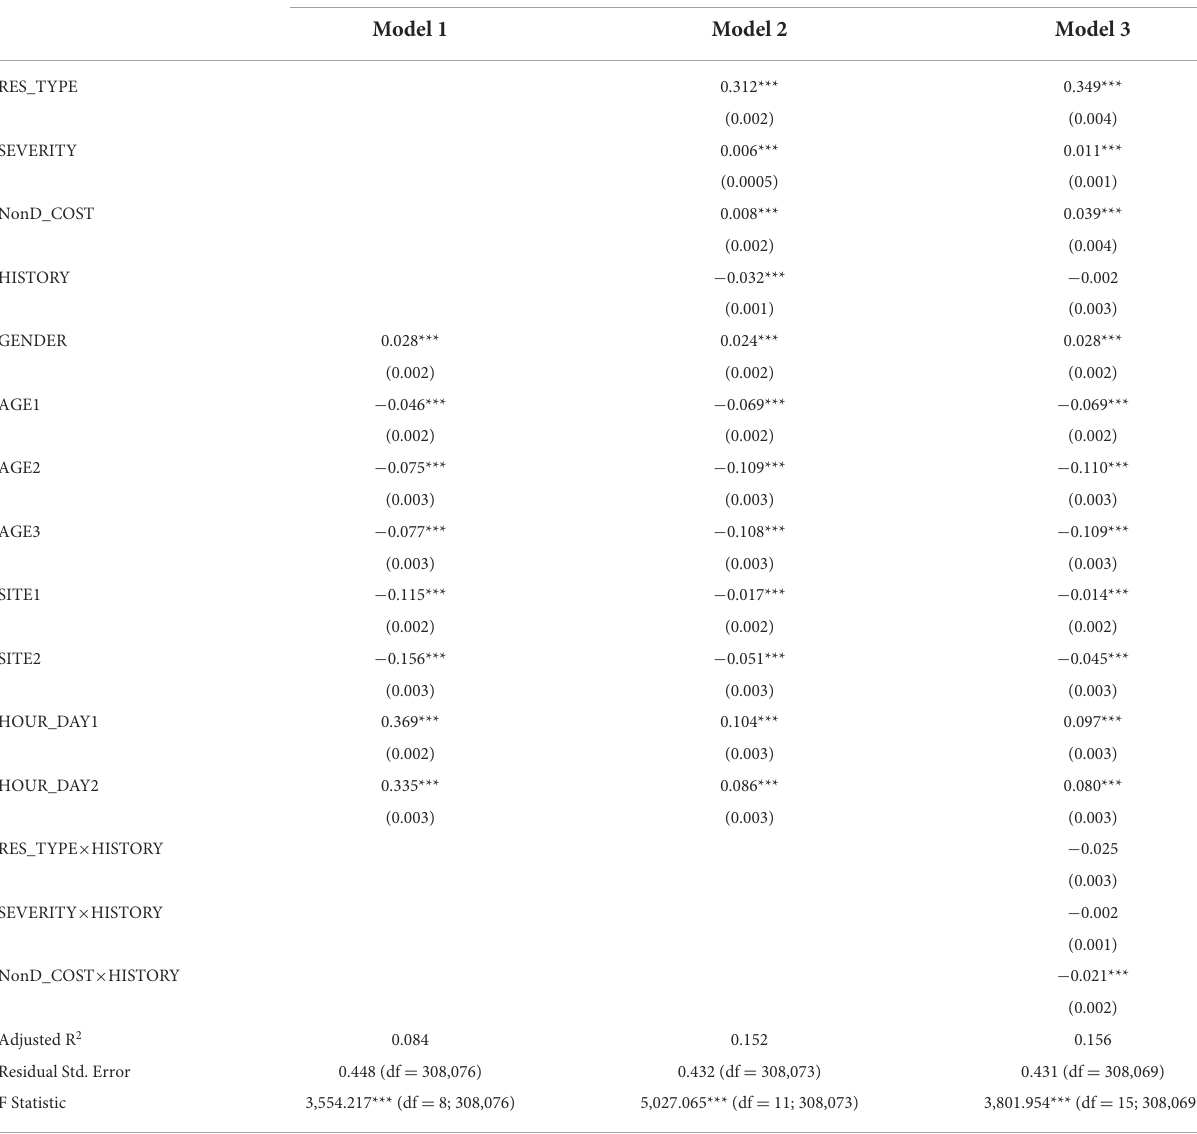
TABLE 6 Results for three determinants-appointment